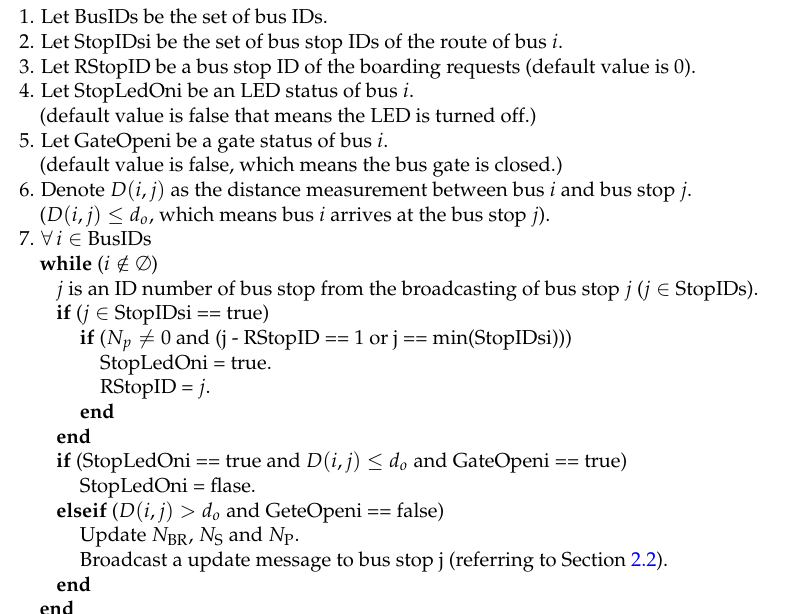
Table 3. Software design of bus information system.